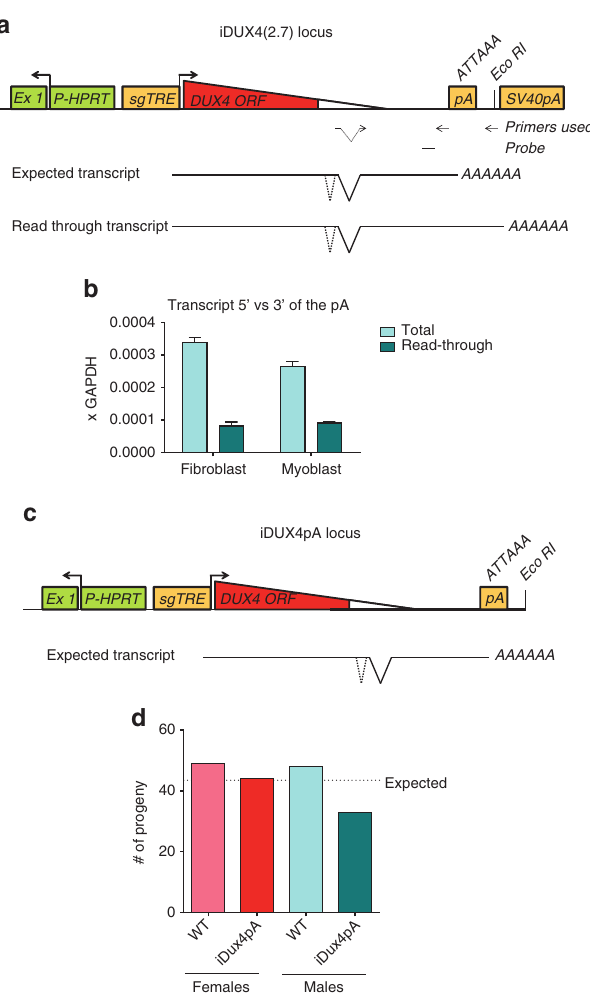
MalesFibroblast0.00000.00010.00020.00030.0004 Fig. 1 DUX4 poly A signal read through and the effect of removing the SV40 pA signal. a Schematic of transgene integration in iDUX4[2.7] mice and primers/probe used for detection of transcript proximal to and distal of the DUX4 pA signal. Note the SV40 poly A signal downstream of the DUX4 poly A signal. b RTqPCR with reverse primers on either side of the DUX4 pA signal in PDGFR α + integrin α 7 – ( fi broadiopgenic) and PDGFR α – integrin α 7 + (myogenic) sorted cultured primary muscle cells. n = 3 technical replicates. Note the large amount of transcript that is detected by the primer downstream of the DUX4 pA, indicating that the DUX4 poly A is not ef fi cient and allows a high level of read through. In the iDUX[2.7] mouse, these read through transcripts are stabilized by the SV40 poly A, potentiating higher basal levels of DUX4 in the off state. c The transgene is targeted 5 ʹ of HPRT , is regulated by a second generation tetracycline-response element, includes DUX4 and 3 ʹ UTR including the DUX4 poly A signal. d Mice were made in which the SV40 pA was removed, leaving only the endogenous, less ef fi cient, DUX4 pA. Viability is now near-normal for male carriers. Summary of 174 genotypes of 3-week old mice from 21 litters of iDUX4pA females backcrossed to males with a WT chrX. Results are not signi fi cantly different from expected for the hypothesis of no selection against iDUX4pA ( χ 2 , two tailed p = 0.2956), but are strongly diverged from expected ( p < 0.0001) for the hypothesis that iDUX4pA is selected against at the same level as observed against iDUX4[2.7] 20 . Thus, we conclude that the presence of the DUX4 poly